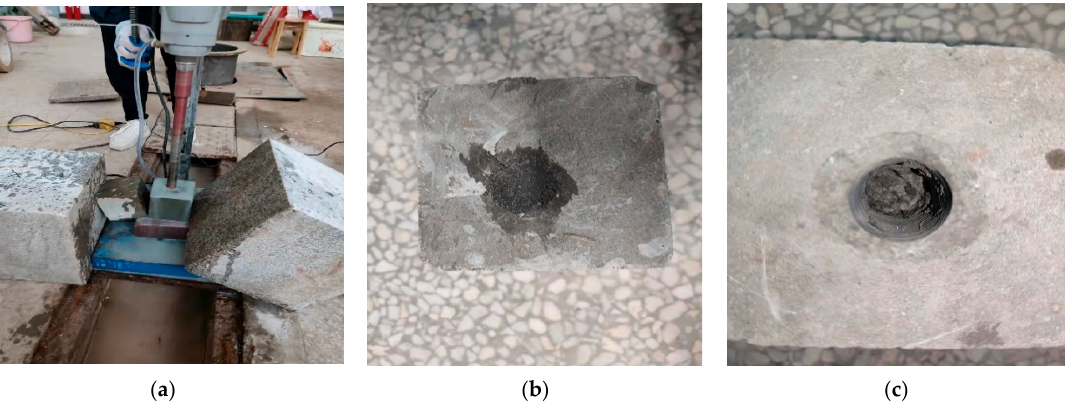
Figure 2. Interface shear strength test block; ( a ) boring a hole; ( b ) front of block; ( c ) bare face of block.